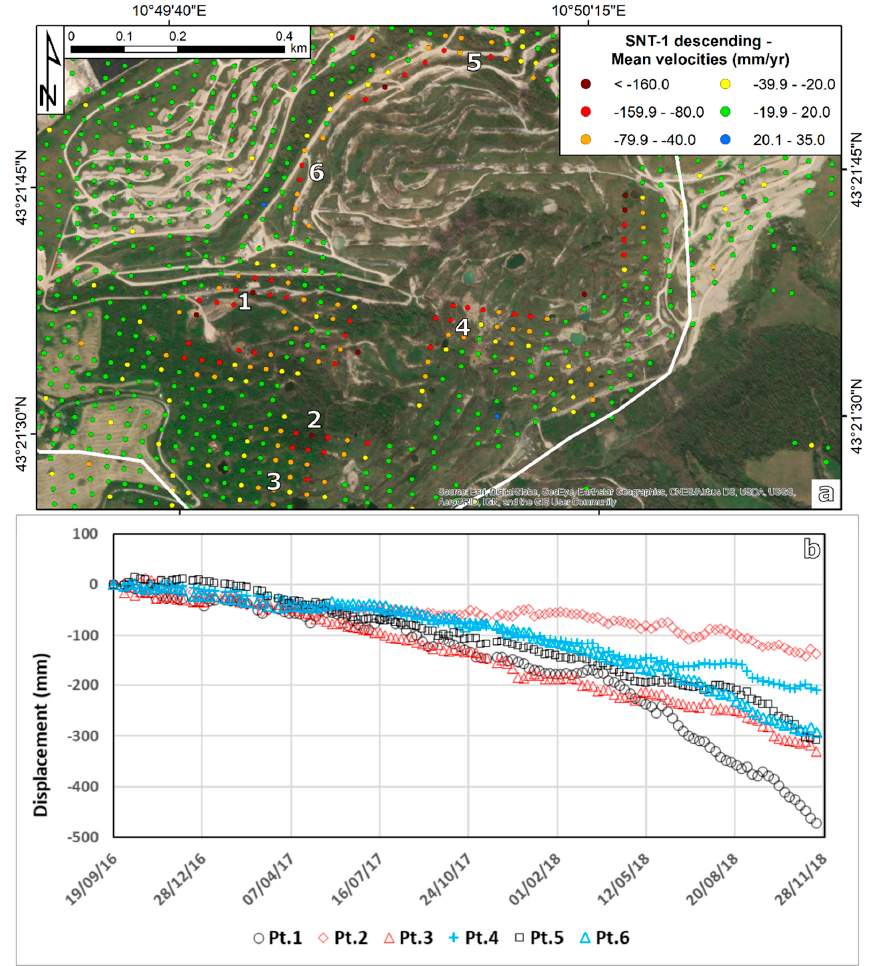
Figure 7. ( a ) Deformation map for the mining area of Poppiano-Volterra. Numbers 1 to 6 indicate areas where the time series of inset ( b ) have been extracted. The background image of inset ( a ) is an ESRI World Image.